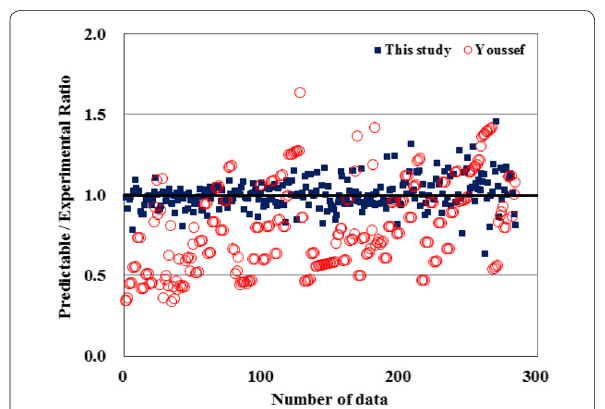
Fig. 8 Prediction ratio confined concrete between Youssef’s research and this